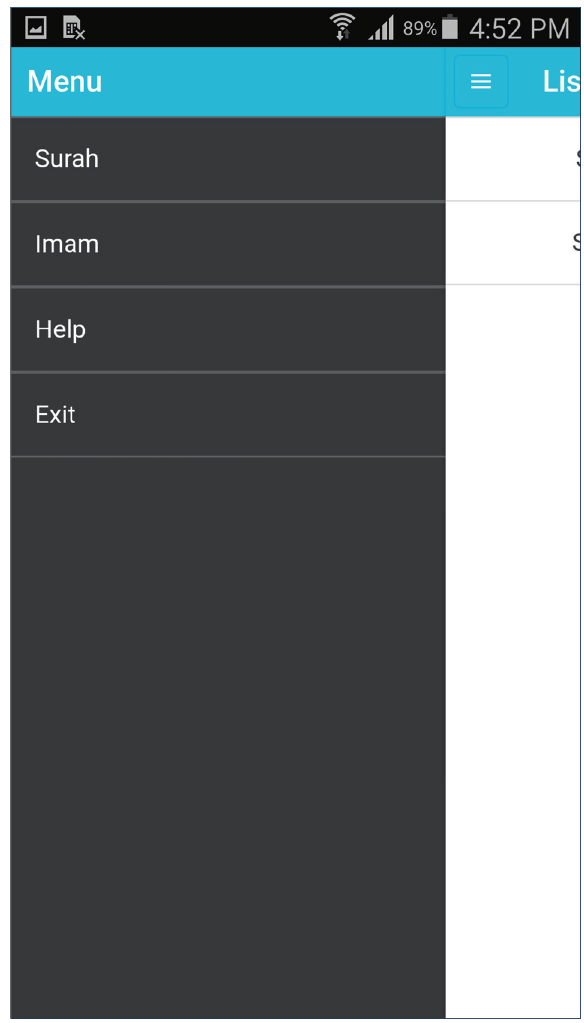
Figure 4: Menu options. Figure 3: Landing